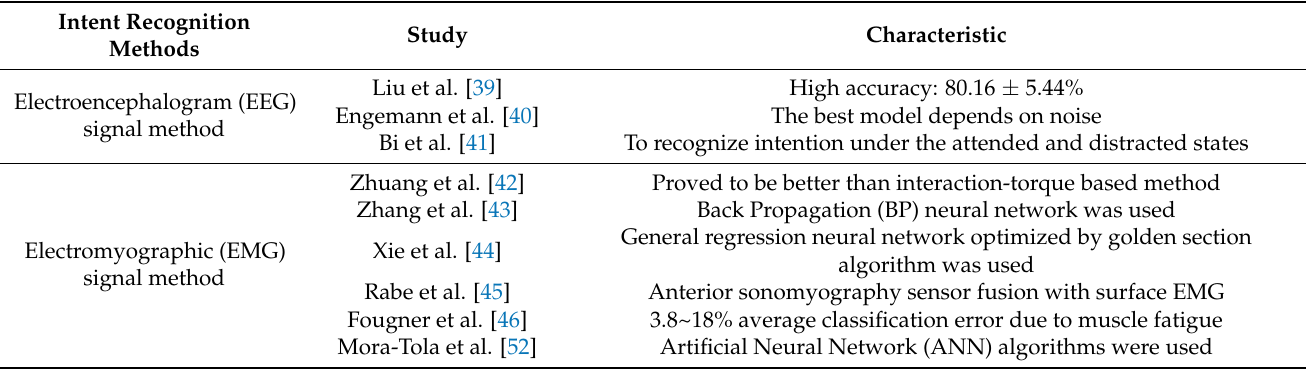
Table 2. Intent recognition method used in each of the included studies and their